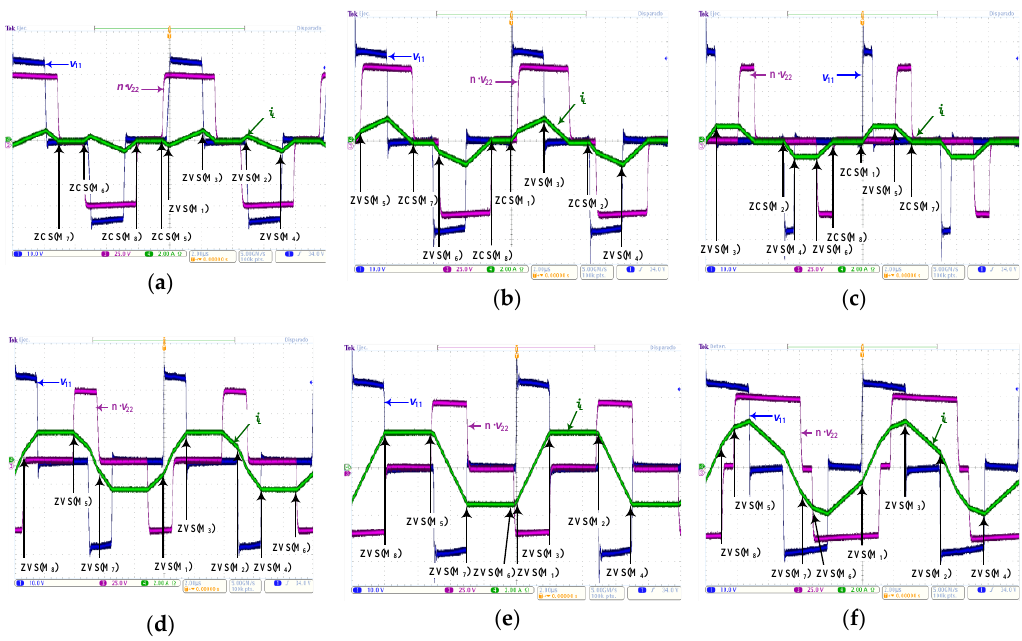
Figure 13. Switching modes for Case II: ( a ) SM 1 for D 1 = 0.44, D 2 = 0.664, and φ/π = 0.048; ( b ) SM 2 for D 1 = 0.42, D 2 = 0.656, and φ/π = 0.206; ( c ) SM 3 for D 1 = 0.132, D 2 = 0.2, and φ/π = 0.458; ( d ) SM 4 for D 1 = 0.312, D 2 = 0.34, and φ/π = 0.806; ( e ) SM 5 for D 1 = 0.221, D 2 = 0.435, and φ/π = 0.896; ( f ) SM 3 * for D 1 = 0.564, D 2 = 0.838, and φ/π = 0.521.